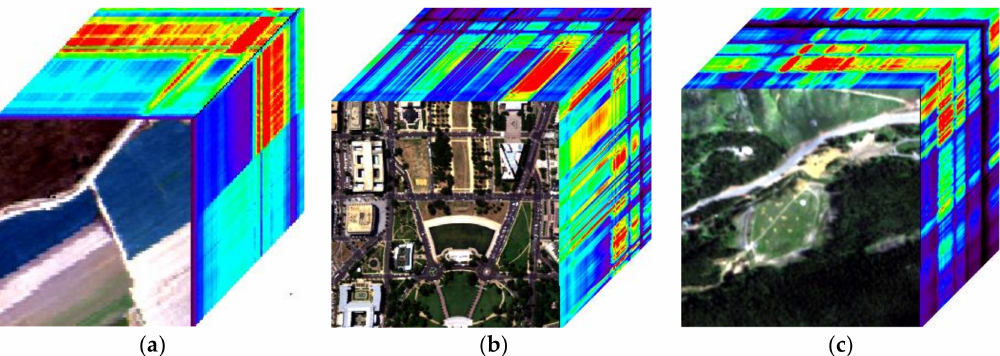
Figure 1. Experimental Reference Datasets: ( a ) hyperspectral image of Salinas; ( b ) hyperspectral image of Washington D.C.; ( c ) hyperspectral image of